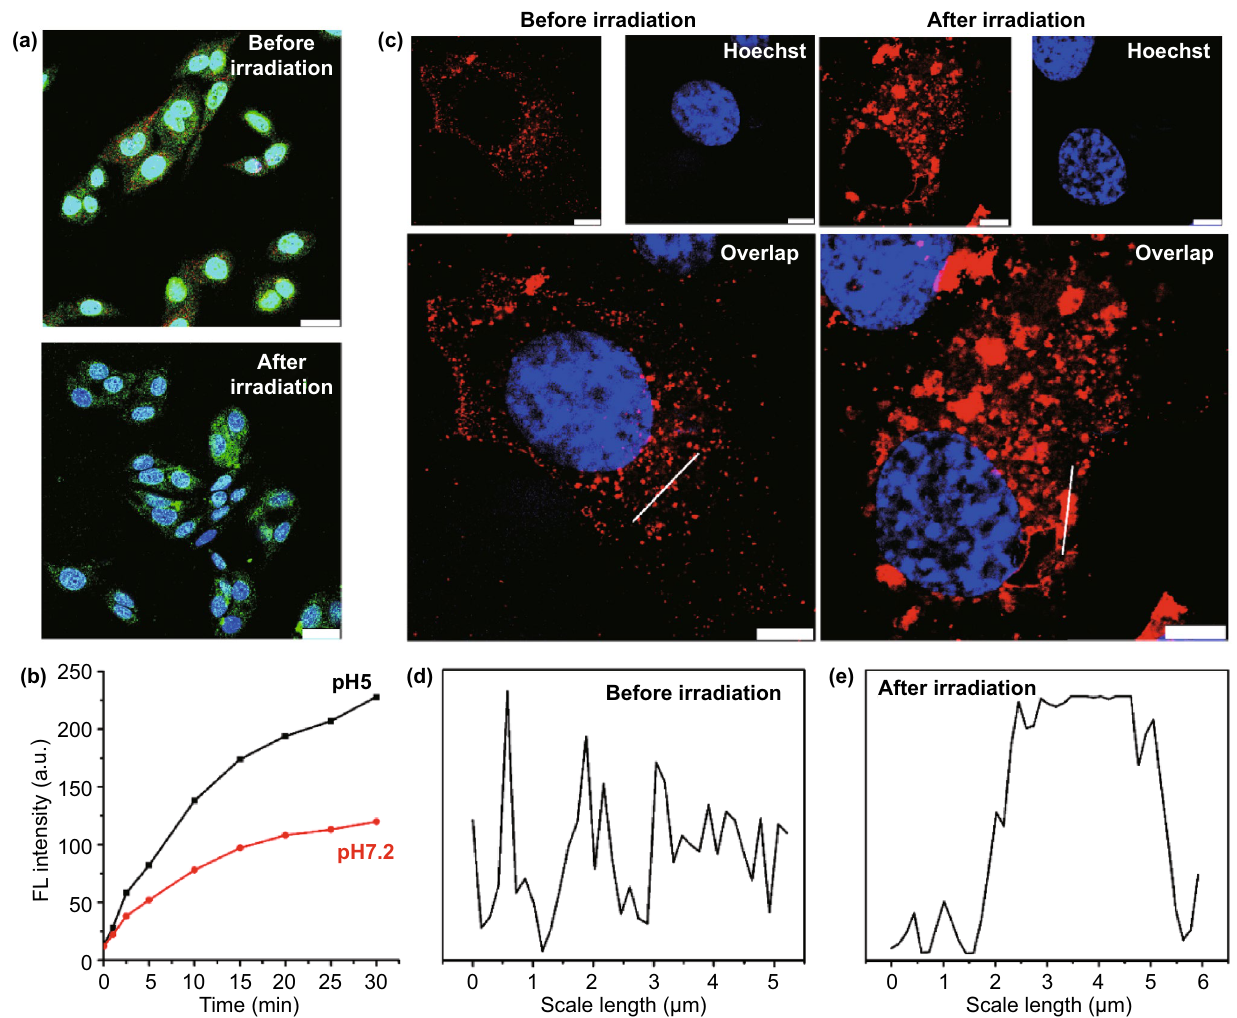
Fig. 3 Lysosomal escape of sPPDN. a Observation of lysosomal disruption of H1299 cancer cells treated with sPPDN before and after light irradiation (10 mW cm −2 , 5 min) using AO staining. AO generates red fluorescence in acidic lysosomes and emits green fluorescence in cytosol and nucleus. Scale bar = 20 μm. b Fluorescence intensity of sPPDN in H1299 cancer cells under different pH conditions. c Confocal fluores- cence images of H1299 cancer cells stained by Hoechst 33,342 after incubation with sPPDN (250 nM) for 2 h before and after light irradiation (10 mW cm −2 , 5 min). Scale bars = 8 μm. d Corresponding fluorescence intensity profiles of the areas marked by white lines in c before irradia- tion. e Corresponding fluorescence intensity profiles of the areas marked by white lines in c after